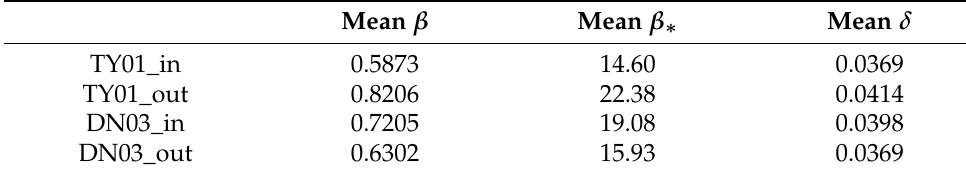
Table 5. Sensitivities of the performance of TY01 and DN03 to β , β ∗ , and δ